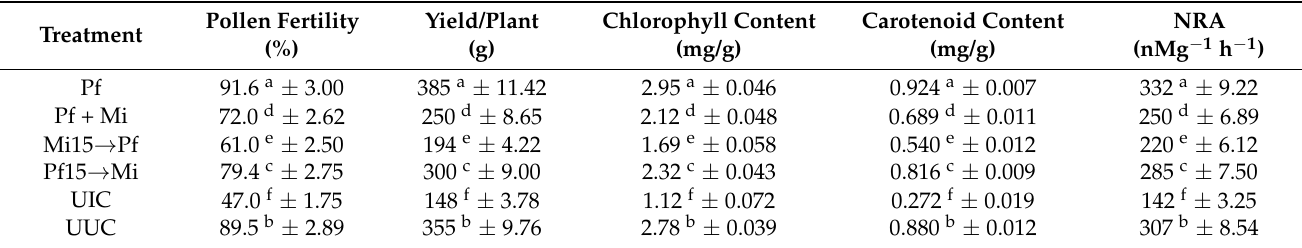
Table 2. Impact of individual, concomitant and sequential inoculation of Meloidogyne incognita and Pseudomonas fluorescens on yield and biochemical parameters of tomato cv. K-21 in